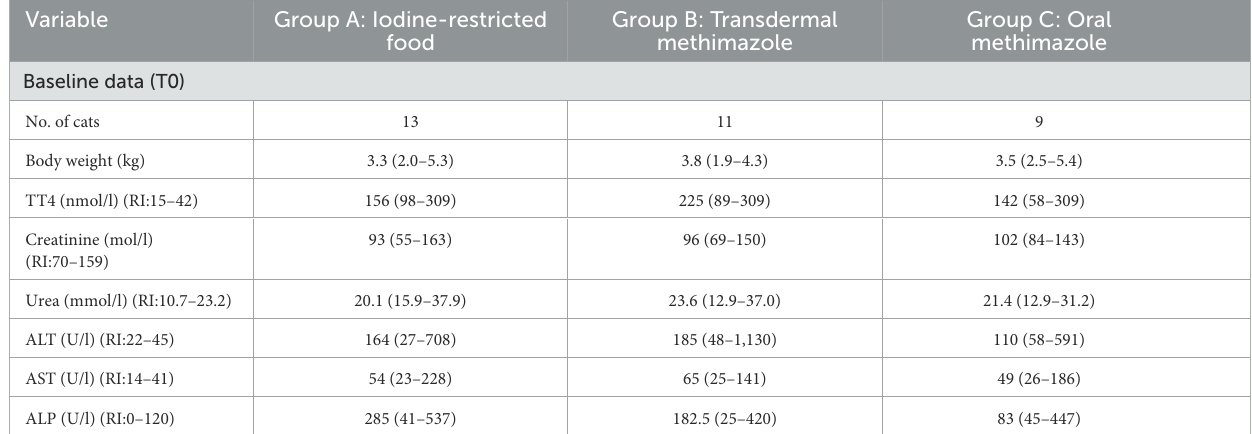
TABLE 2 Clinical and clinicopathological parameters in hyperthyroid cats treated for a 3 months period with iodine-restricted food, transdermal methimazole, or oral methimazole [adapted from Grossi et al. (107)].